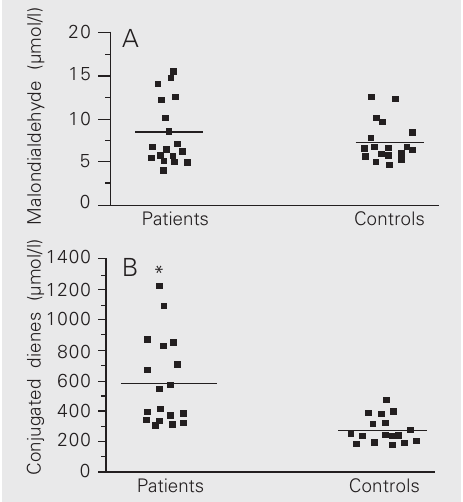
Figure 1. Concentration of lipid oxidation products in plasma and erythrocytes of patients with hepatosplenic schistoso- miasis mansoni. Plasma malon- dialdehyde (A) and erythrocyte- conjugated diene (B) levels in 18 patients with schistosomia- sis, who had been treated by splenectomy, obliterative suture of the esophageal varices, liga- ture of the left gastric vein, and auto-implantation of spleen tis- sue. *P < 0.05 compared to controls (unpaired Student t -